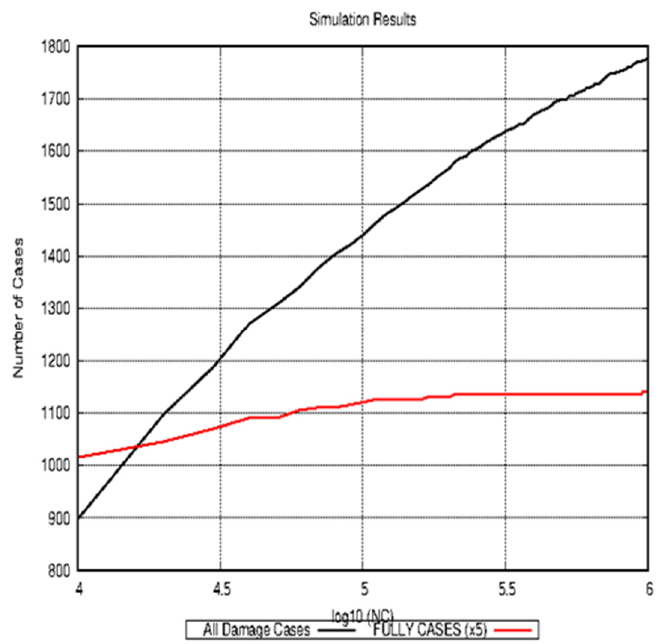
Figure 3. Simulation results for the EMSA2-RoPax. Black curve: Number of damage cases. Red curve: 5× Number of “fully” damaged cases.